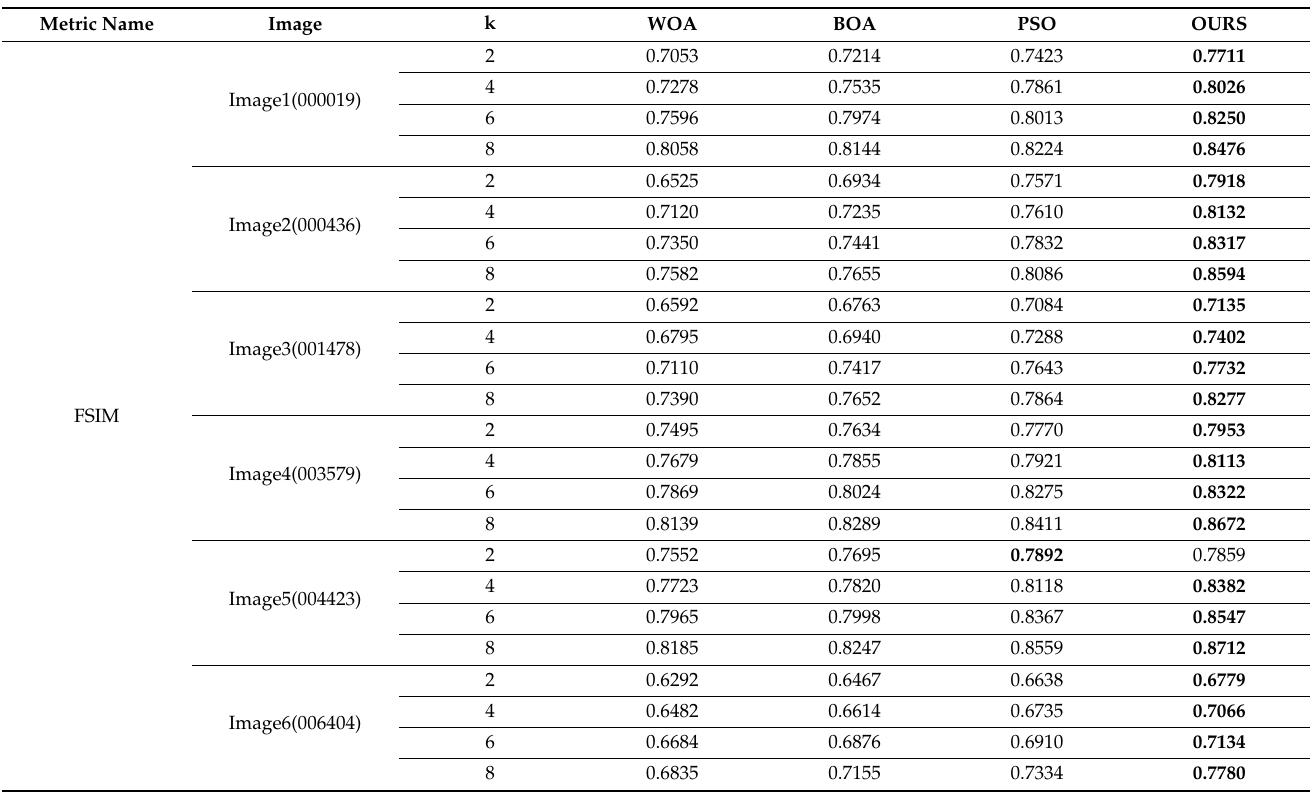
Table 5. Comparison of FSIM in images a–f.